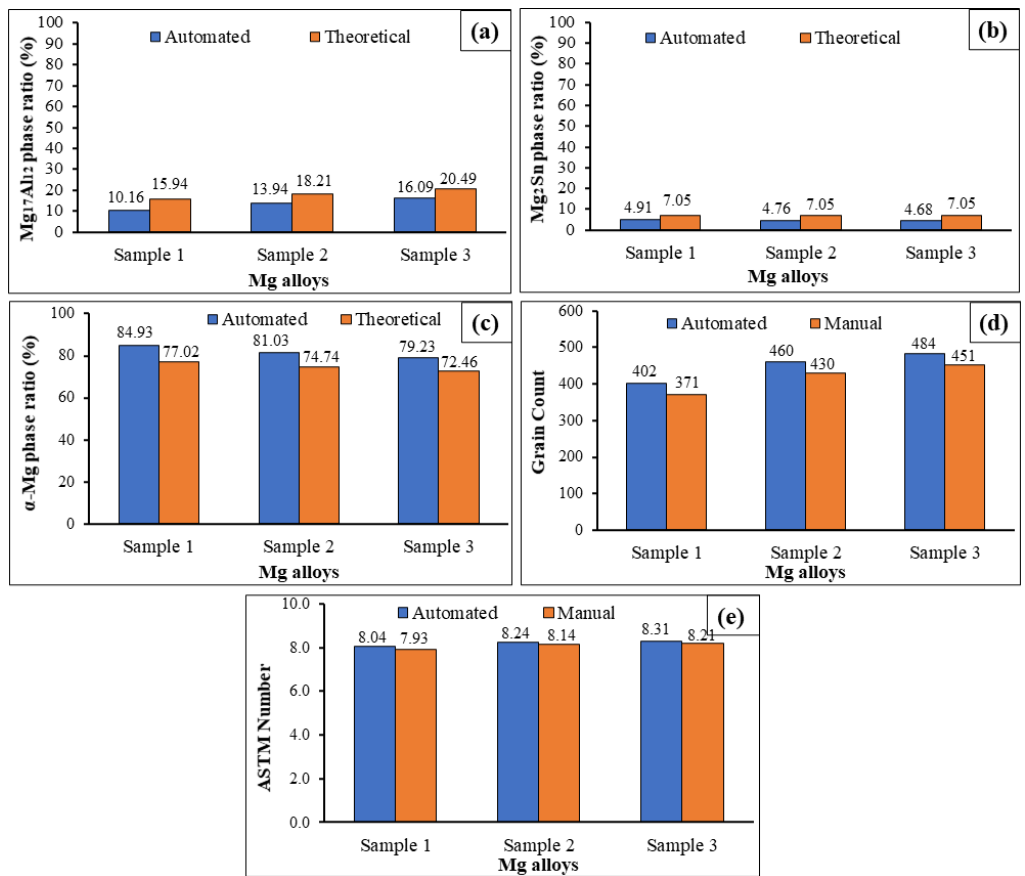
Figure 8. ( a ) Mg 17 Al 12 phase ratio, ( b ) Mg2Sn phase ratio, ( c ) α -Mg phase ratio, ( d ) grain count, ( e ) ASTM grain size num- bers.